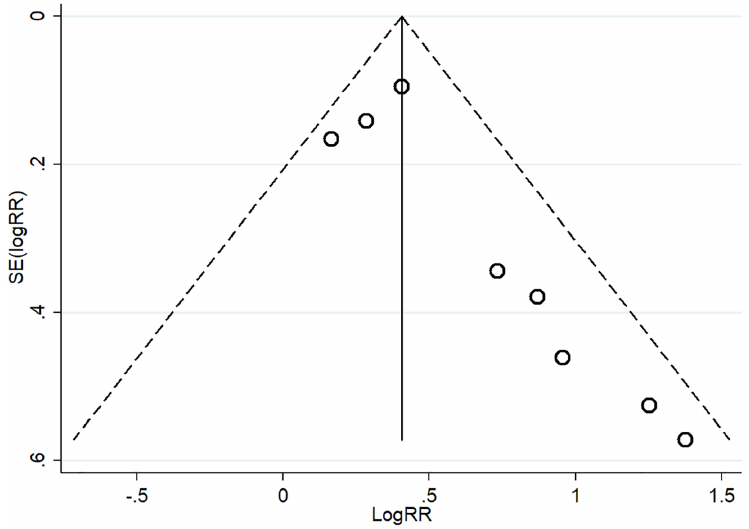
Fig 1. Funnel plot of the studies assessing the association between the DII score and prostate cancer risk.